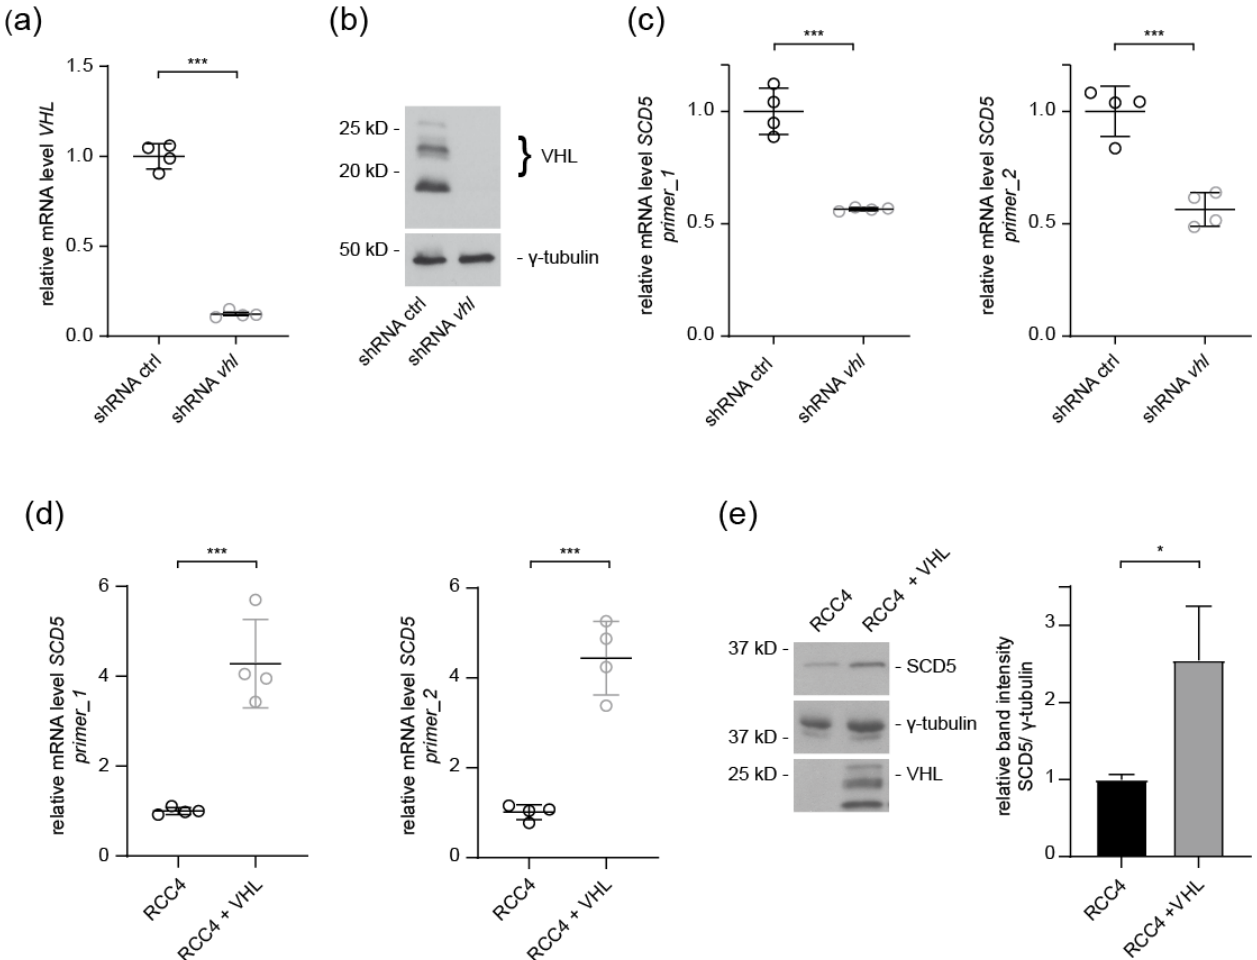
Figure 2. SCD5 expression in ccRCC cells is VHL dependent. ( a ) mRNA levels of VHL in HeLa cells infected with inducible control-shRNA or VHL -specific shRNA assayed by RT-qPCR; HSPCB was used as the reference gene. n = four. Data are presented as mean ± SEM. *** p < 0.001 ( t -test). ( b ) Representative blot showing VHL expression in HeLa cells infected with lenti-control shRNA or lenti-VHL shRNA. Full-length blots are presented in Supplementary Figure S2. ( c ) SCD5 mRNA levels are affected by VHL. qPCR analysis of HeLa cells expressing shRNA against control or VHL. Two different primer sets were used for SCD5 mRNA analysis; HSPCB was used as the reference gene. n = four for each experiment. Data are mean ± SEM. *** p < 0.001 ( t -test). ( d ) Analysis of SCD5 mRNA levels in RCC4 cells and RCC4 cells expressing VHL. Cell lysates were prepared from VHL -deficient RCC4 cells and cell lines transduced with VHL (RCC4 + VHL); GAPDH was used as the reference. n = four for each experiment. Data are mean ± SEM. *** p < 0.001 ( t -test). ( e ) Western blot demonstrating SCD5 expression in RCC4 cells ( VHL deficient) and RCC4 cells transduced with VHL. Full-length blots are presented in Supplementary Figure S2. Right panel shows quantification of relative SCD5 levels from three independent experiments. * p < 0.05 ( t -test).